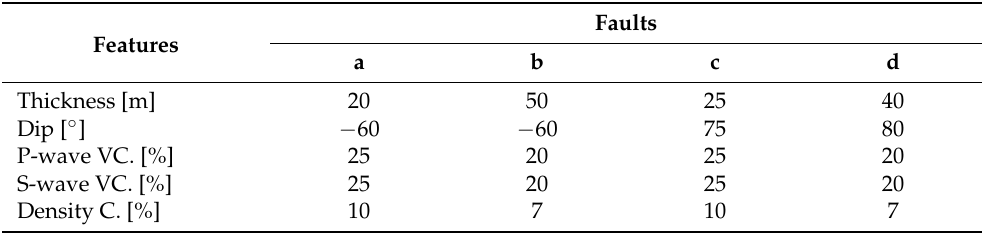
Table 3. Fault features of the multi-fault experiment. The VC. Stand the Velocity Contrast (idem to C). The fault locations are shown in Figure